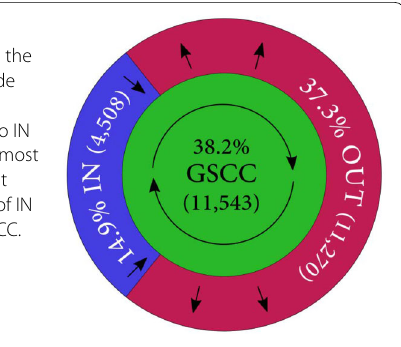
Table 5 “Walnut” structure: shortest distance from GSCC to IN/OUT IN to GSCC OUT from